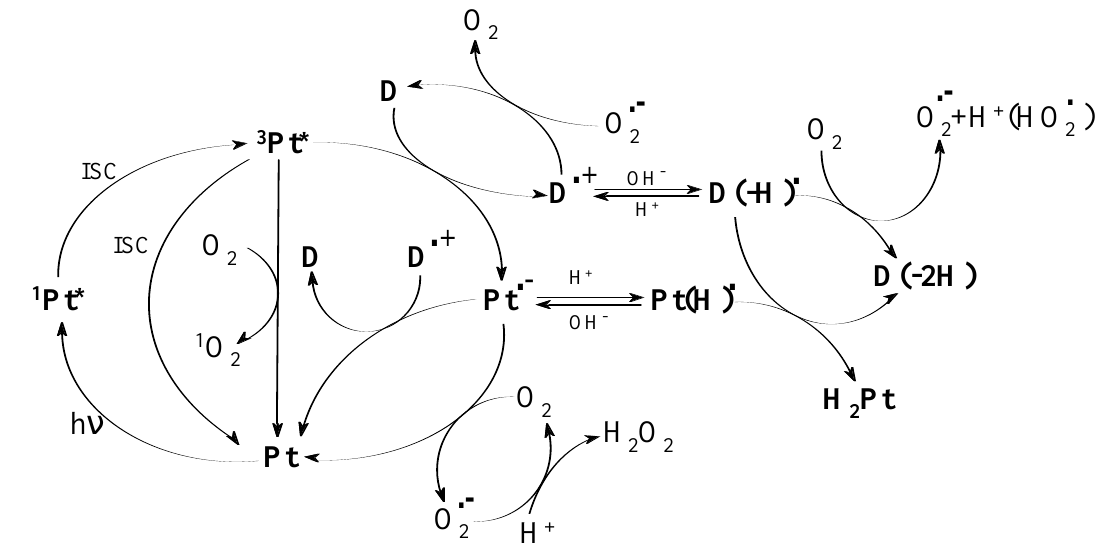
Figure 6. Overall mechanism of electron transfer processes photoinduced by pterins (Pt) (D = electron